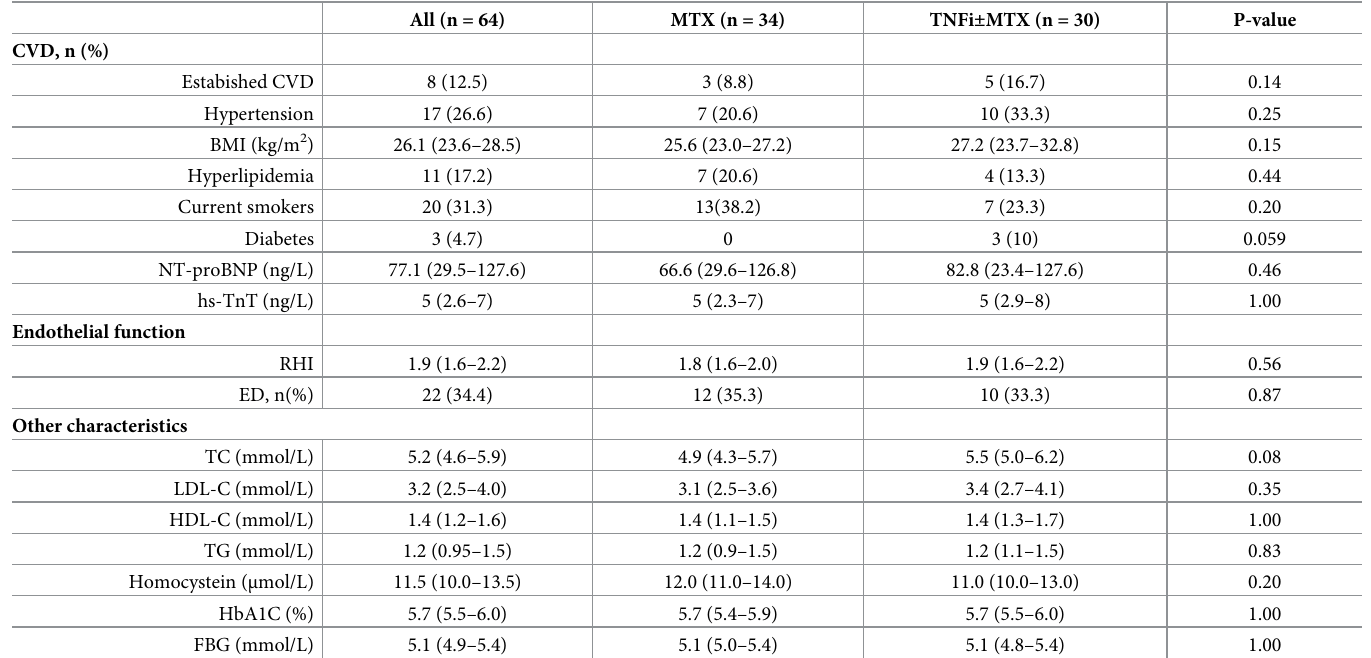
Table 2. Baseline cardiovascular